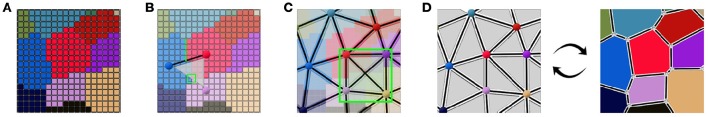
Abstracting an adjacency simplicial complex from a 2D segmented image: cells as connected regions of labeled pixels (A), extraction of adjacency simplices from pixel neighborhoods (B), the set of adjacency simplices not necessarily forming a simplicial complex (C), and the reconstructed valid simplicial complex converting directly into the geometry cellular complex through dualization (D).